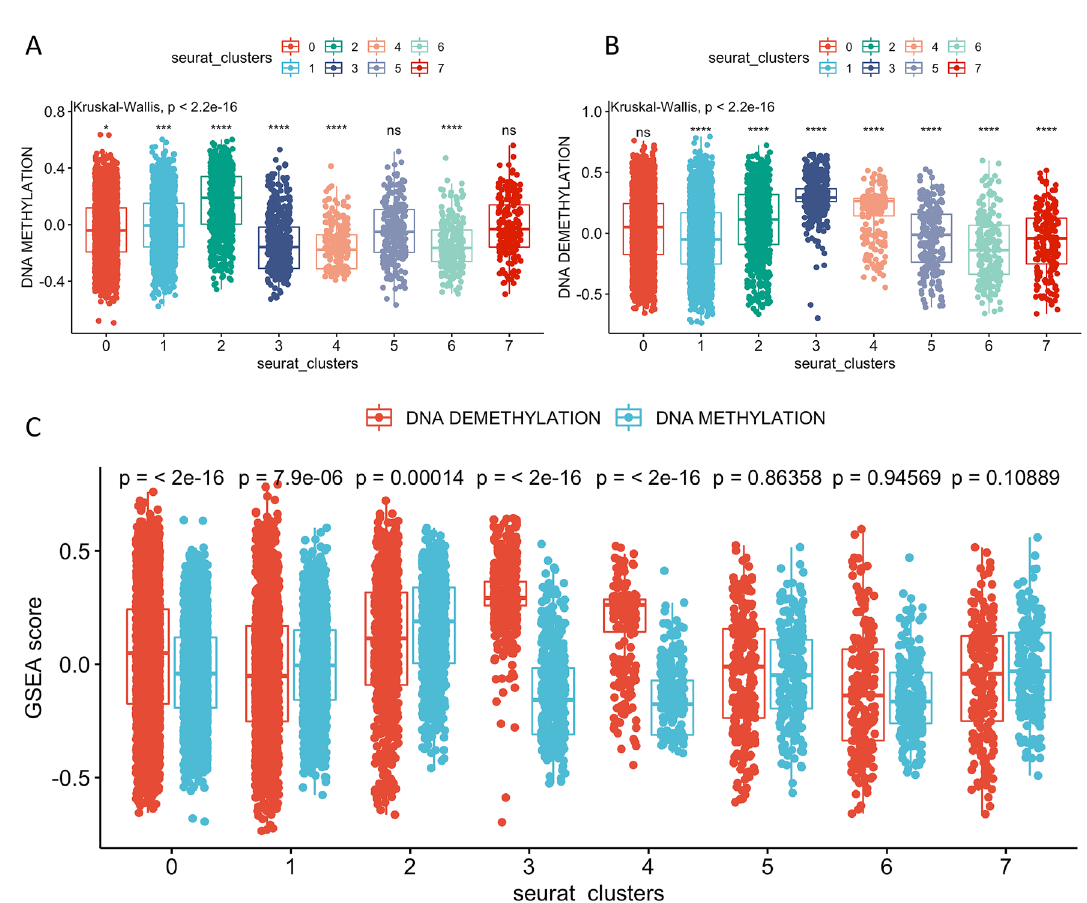
Figure 4. Methylation scores ( A ) and demethylation scores ( B ) for each cluster compared with all the others, and Gene Set Enrichment Analysis scores for methylation and demethylation scores within the same cluster ( C ). Boxplots show medians, interquartile ranges, and outliers. ns: p > 0.05; * p ≤ 0.05; ** p ≤ 0.01; *** p ≤ 0.001; **** p ≤